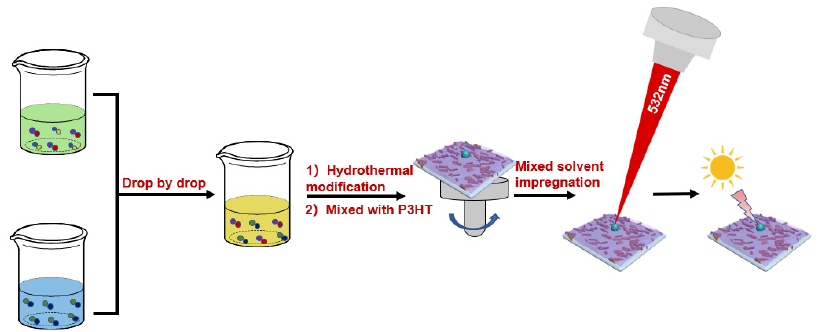
Figure 1. P3HT@Ag 2 NCN preparation of composite substrate and schematic of the SERS experi-